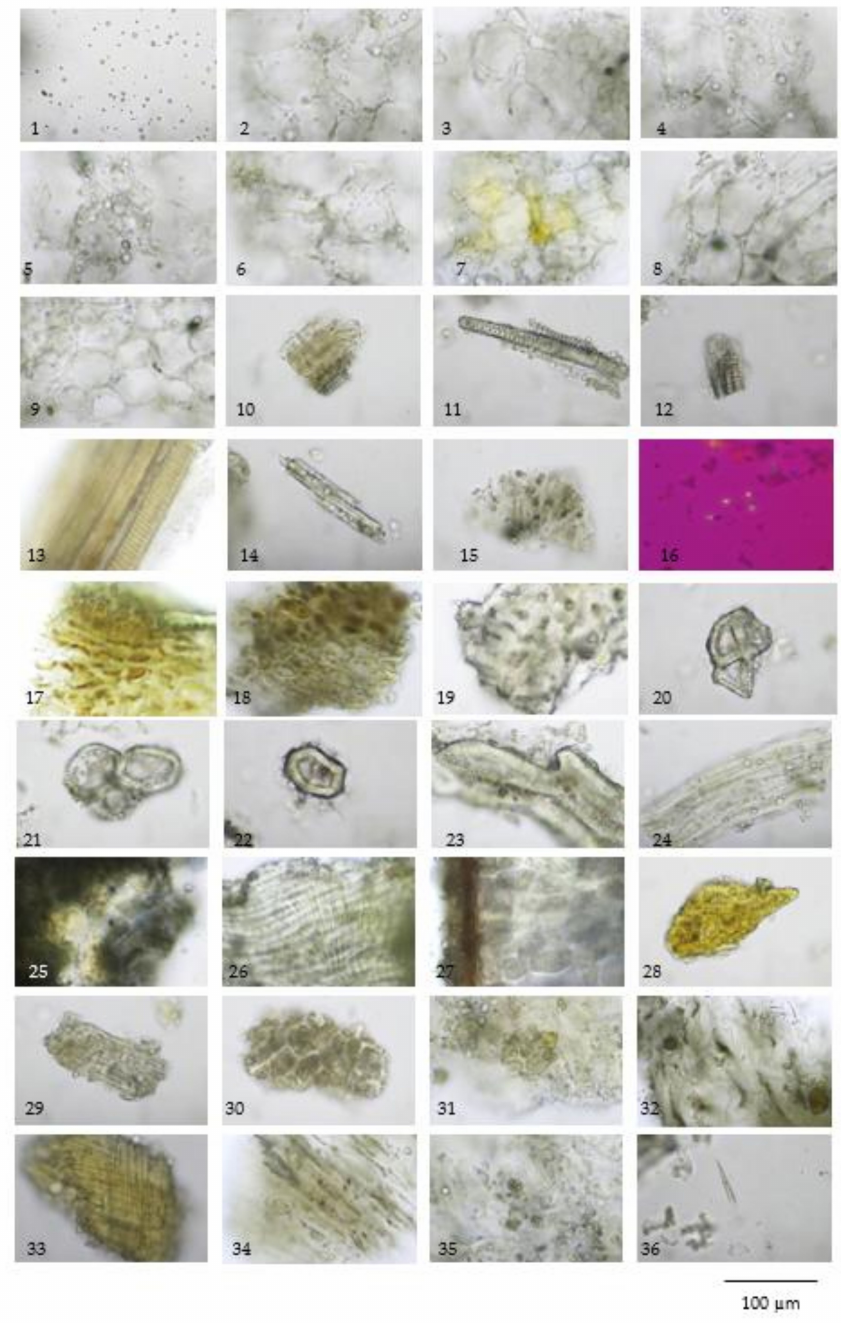
Figure 5. Diagnostic characteristics of Pikad Tri-phol-sa-mut-than (TS): ( 1) oil droplets; ( 2 , 3 ) thin-walled parenchyma; ( 4 – 7 ) parenchyma and oil droplets; ( 8 , 9 ) thick-walled parenchyma; ( 10 – 13 ) various size of vascular bundle; ( 14 ) isolated sclereids; ( 15 ) microspheroidal calcium oxalate crystals; ( 16 – 24 ) Aegle marmelos (L.) Corr ê a fruit powder; ( 16 ) microspheroidal calcium oxalate crystals under polarized light; ( 17 ) epicarp in sectional view; ( 18 ) thick-walled parenchyma of epicarp; ( 19 , 20 ) group of sclereids from mesocarp; ( 21 ) group of sclereids from mesocarp; ( 22 ) isolated sclereid; ( 23 ) sclereids from endocarp; ( 24 ) seed hair; ( 25 – 29 ) Coriandrum sativum L. fruit powder; ( 25 ) epicarp in surface view; ( 26 ) group of fusiform sclereid of mesocarp; ( 27 ) seed in sectional view; ( 28 ) fragment of vittae; ( 29 ) endocarp in surface view; ( 30 ) endosperm; ( 31 – 36 ) Morinda citrifolia L. fruit powder; ( 31 ) epicarp; ( 32 ) thickening-walled parenchyma of fruit pulp; ( 33 ) fibrous layer of seed coat; ( 34 ) parenchyma with raphide; ( 35 ) protein bodies; and ( 36 ) acicular